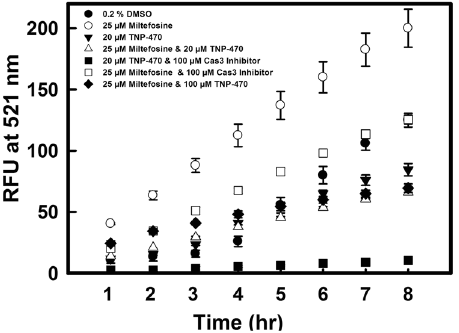
Figure 2. Activation of Caspase-3/7 like proteases inside L . donovani promastigote cells. Control cells (0.2% DMSO), promastigotes induced with 25 µ M of miltefosine, and by 20 µ M TNP-470, alone or both. TNP- 470 induced and miltefosine induced cell lysates were incubated with 100 µ M of Cas3 inhibitor for 30 min, Miltefosine treated cell lysates were also incubated with 100 µ M of MAP2 inhibitor. Data represents the mean ± SD of three independent